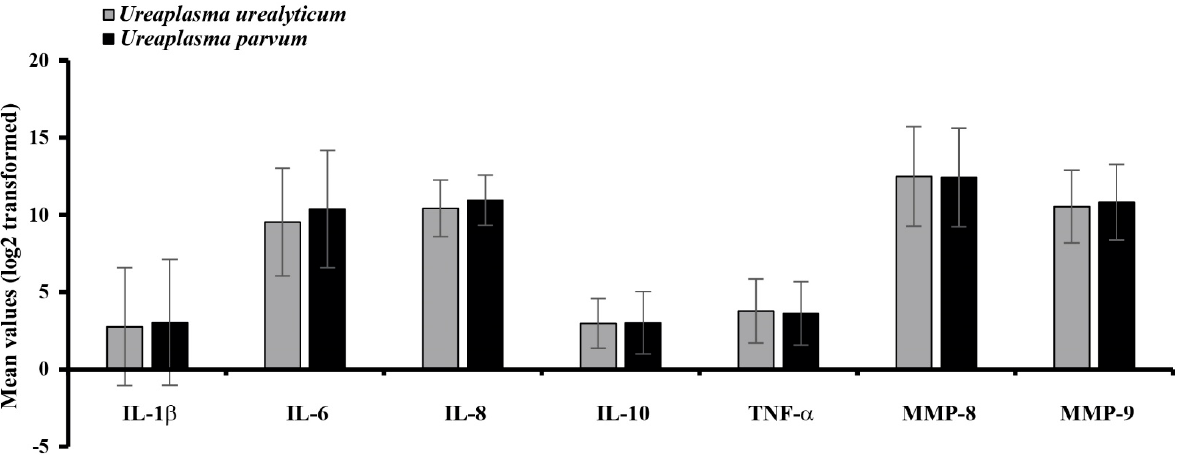
Figure 4. Relative mean values of intraamniotic inflammatory mediators between Ureaplasma parvum and Ureaplasma urealyticum . Interleukin (IL); Tumor necrosis factor (TNF); Matrix metalloproteins (MMP).